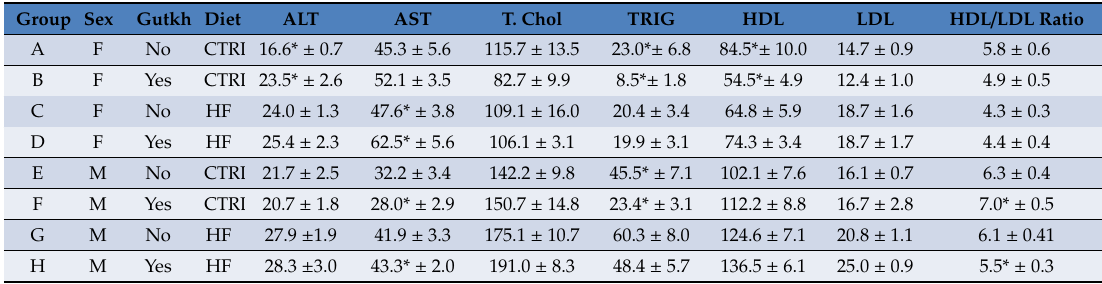
Table 2. Serum cholesterol, ALT and AST levels were higher in mice fed a HFD. Gutkha exposure in utero significantly a ff ected serum lipid, ALT and AST